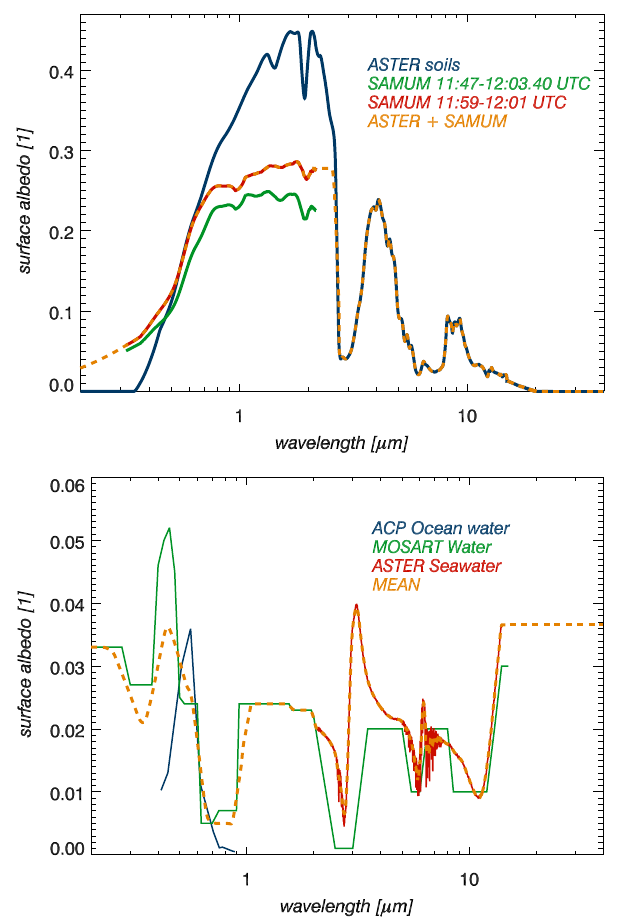
Fig. 3. Averaged spectral surface albedo (dashed orange curves) as used in our solar and thermal radiative transfer simulations. (top) Land surface: 101 datasets, measured on 19 May 2006 during SAMUM-1 (Bierwirth et al., 2009), were averaged over time (green and red curves correspond to different time intervals around noon) and are combined with an averaged soil albedo based on 58 datasets of ASTER (Baldridge et al., 2009). (bottom) Ocean surface: data (blue) received by Schr¨oder (2004) as used in Otto et al. (2007), provided by MOSART (Cornette et al., 1994, green) for water and ASTER for seawater (red) were spectrally